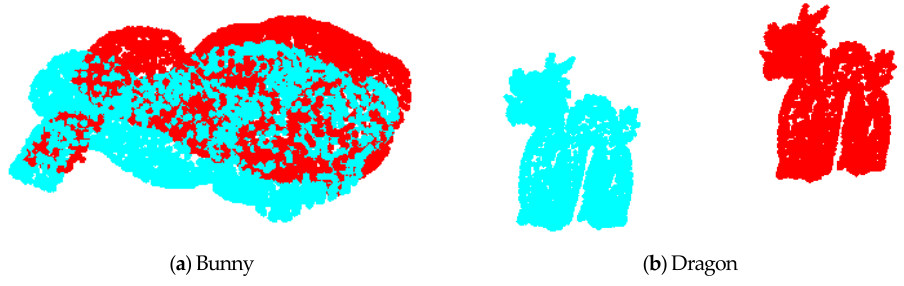
Figure 5. The original point cloud data before matching. Sensors 2017 , 17 , 1